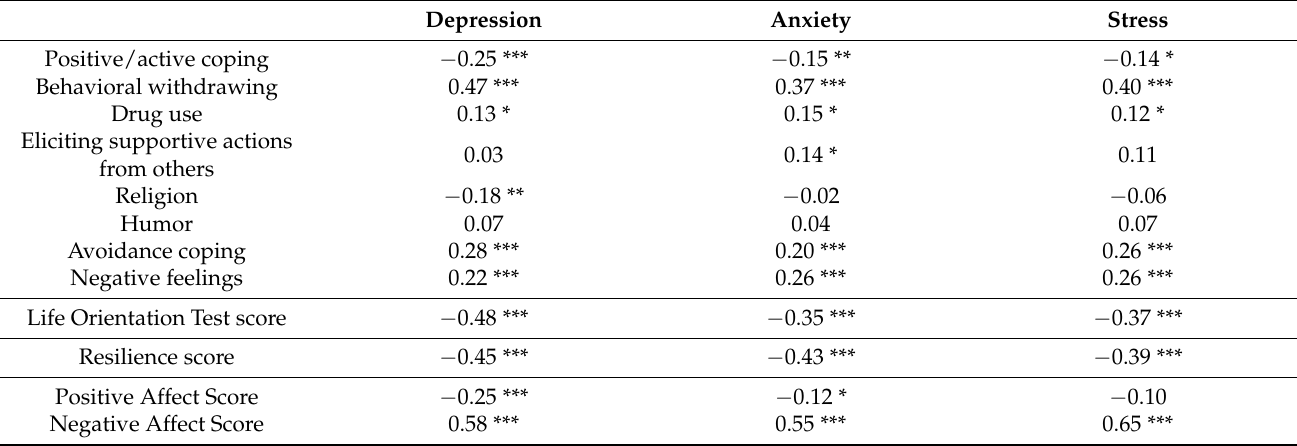
Table 6. Spearman’s correlation coefficients of DASS-21 with BRIEFCOPE, LOT, RES and PANAS. Depression Anxiety Stress